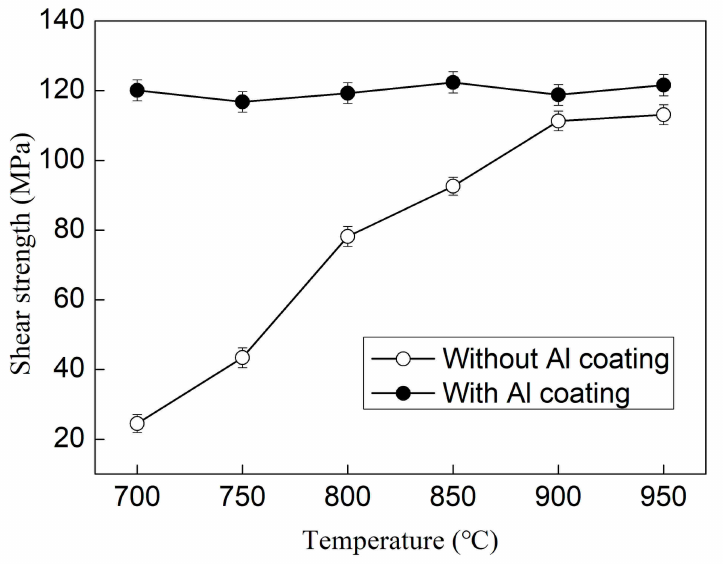
Figure 7. The relationship between the brazed joints shear strength of the two kinds of sample and